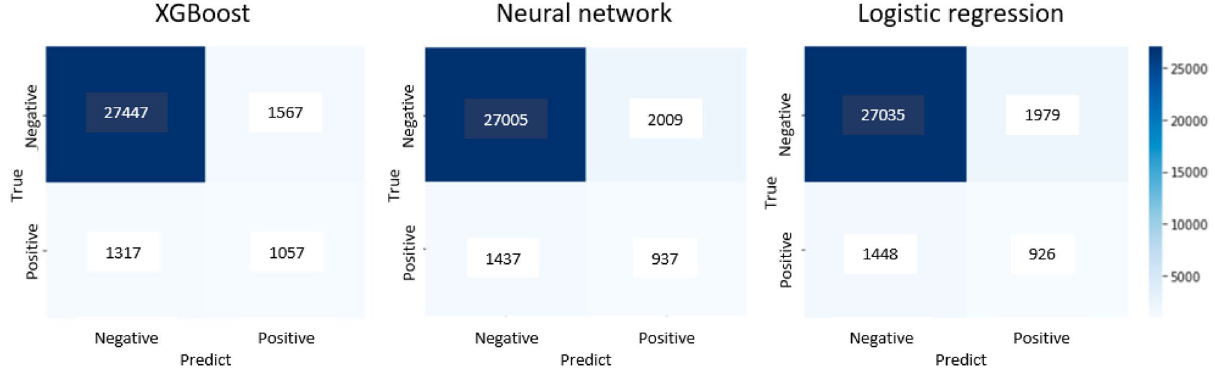
Figure 3. Confusion matrix of the predictive models using test data.